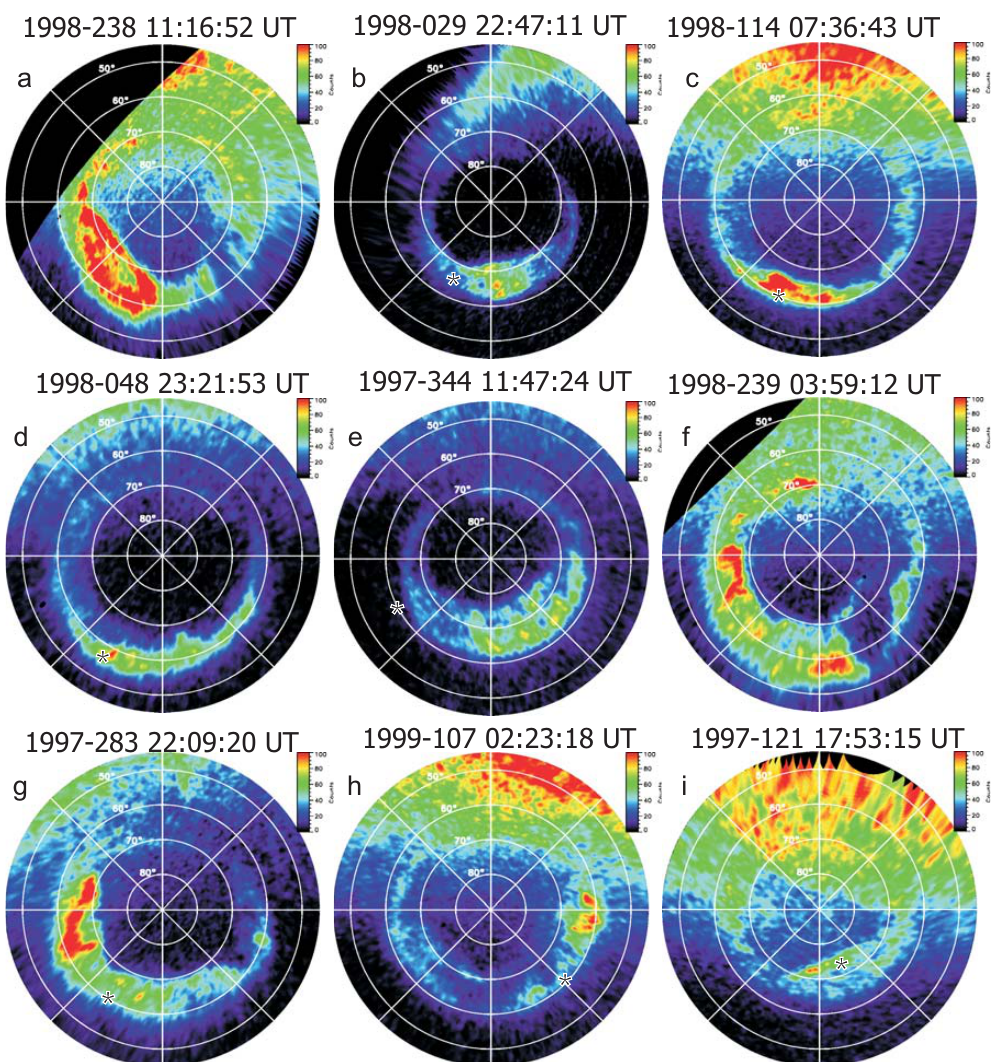
Fig. 3. Examples of auroral events during magnetic storm main phase development. All the images have the same color scale, 0 to 100 counts per pixel. The images have been transformed to a MLT, ILat map with the sun at the top. The onset location, if local, is marked by an asterisk. (a) Best example of a classical bulge-type substorm; (b) an auroral oval brightening of very limited local time extent; (c) a more common auroral oval brightening; (d) a very distributed oval brightening, almost 9h in length at very low latitudes; (e) a large event with a very high latitude boundary; (f) a huge event both in local time and latitude coverage; (g) a dusk-side event; (h) a dawn side event; (i) a polar arc